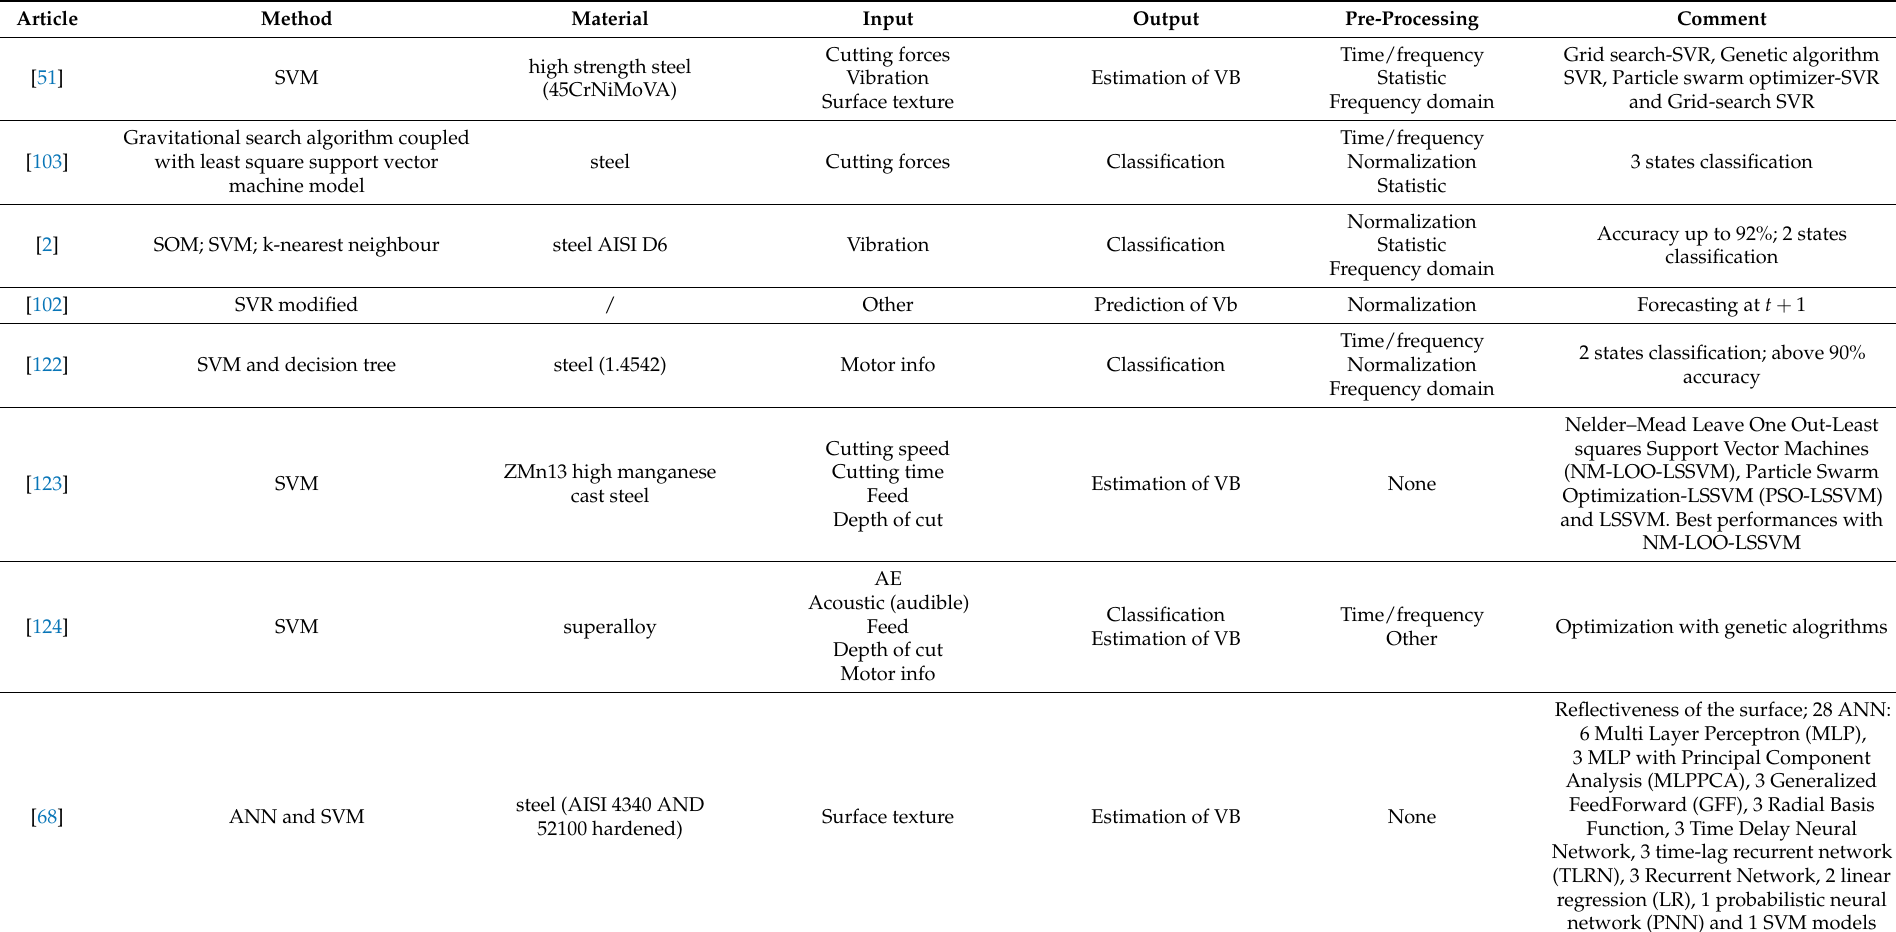
Table A4. General summary of SVM-related